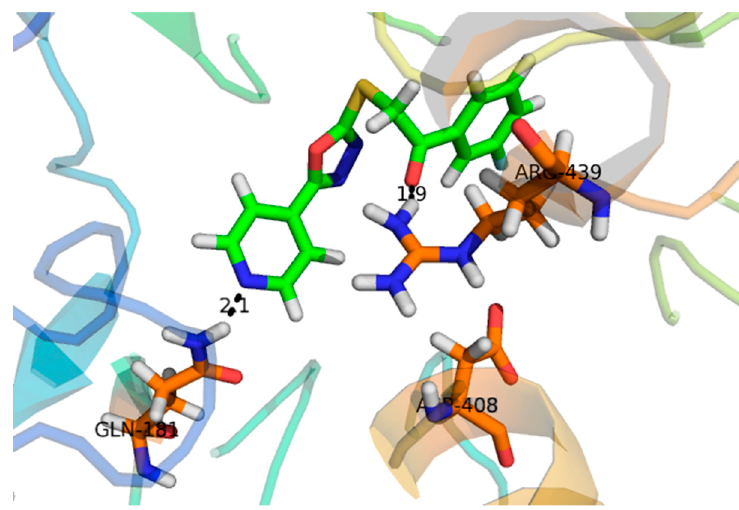
Figure 5. Represent the 3D structures of Compound 3 showing binding potential. Red color in the image shows position of oxygen, green benzene ring, white hydrogen atom, brown color indicates amino acid sequence and blue color indicate nitrogen or amino group.